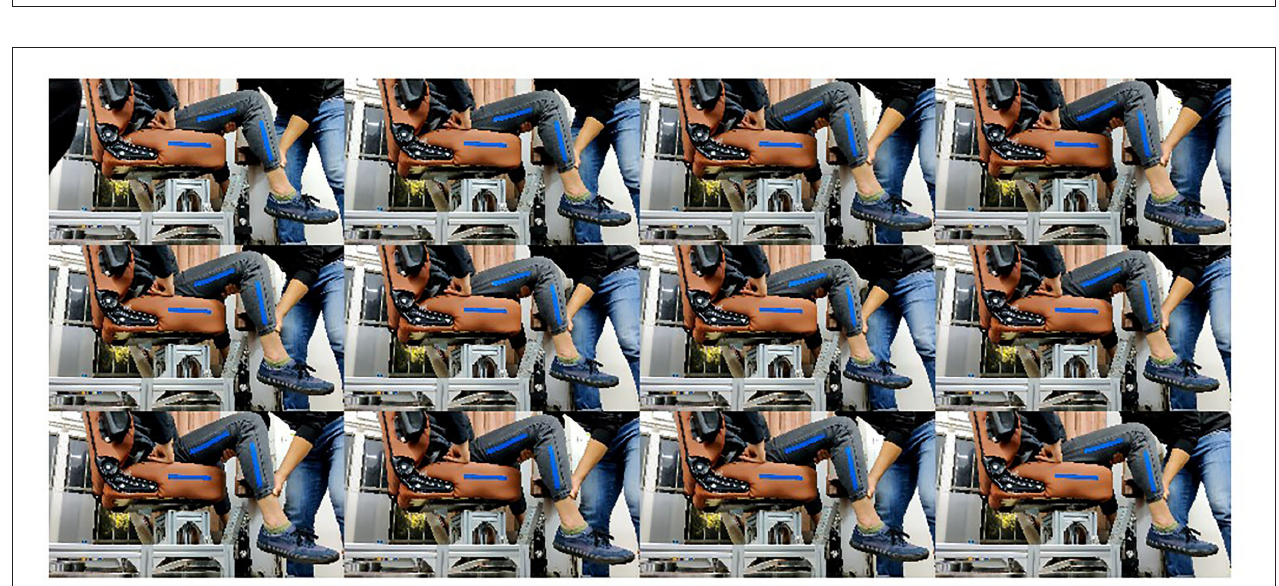
FIGURE 6 | Measurement of the knee joint range of motion in the sagittal plane.